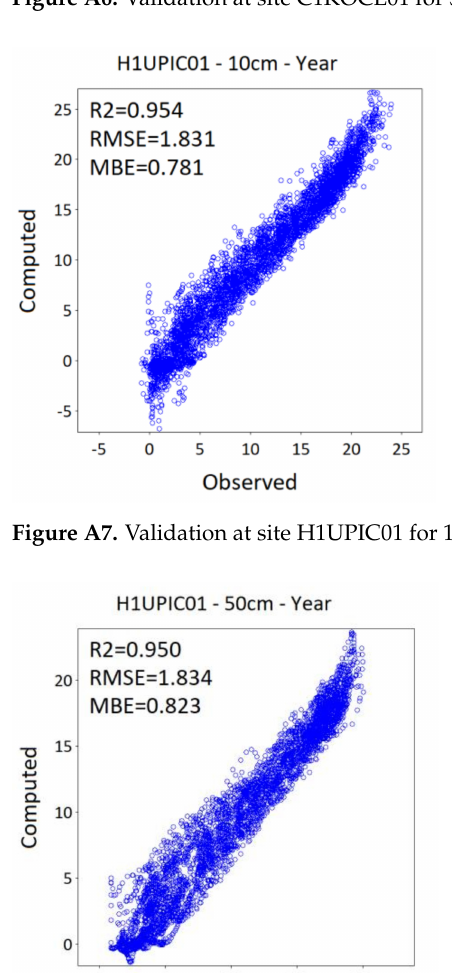
Figure A6. Validation at site C1KOCE01 for 50 cm soil depth.